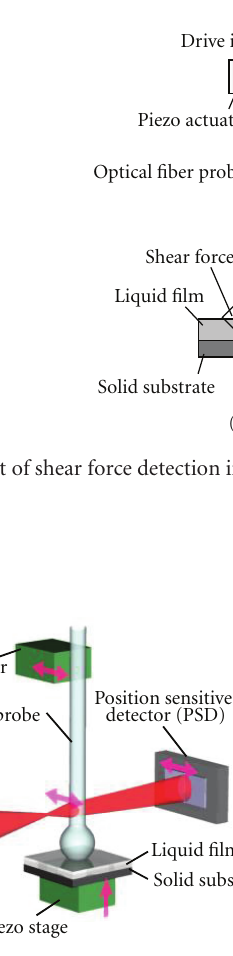
Figure 2: Schematic diagram of the fiber wobbling method (FWM).